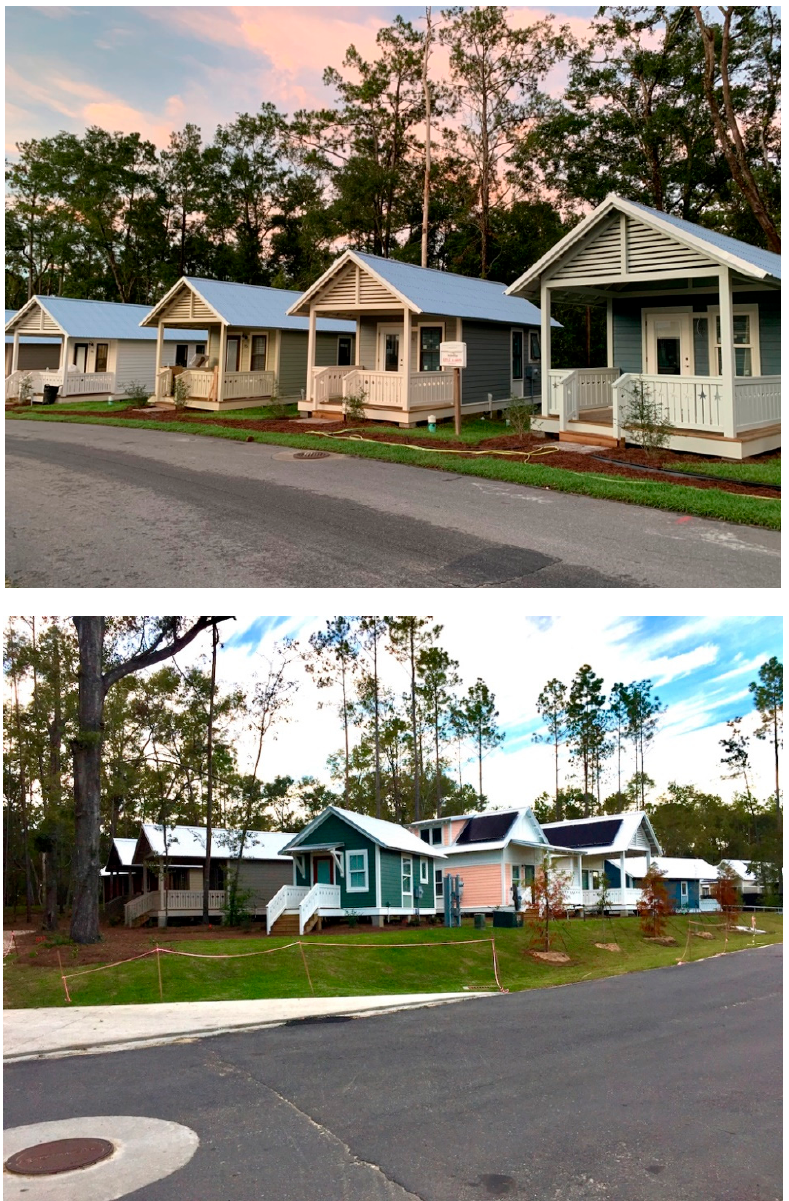
Figure 4. The Dwellings street view.